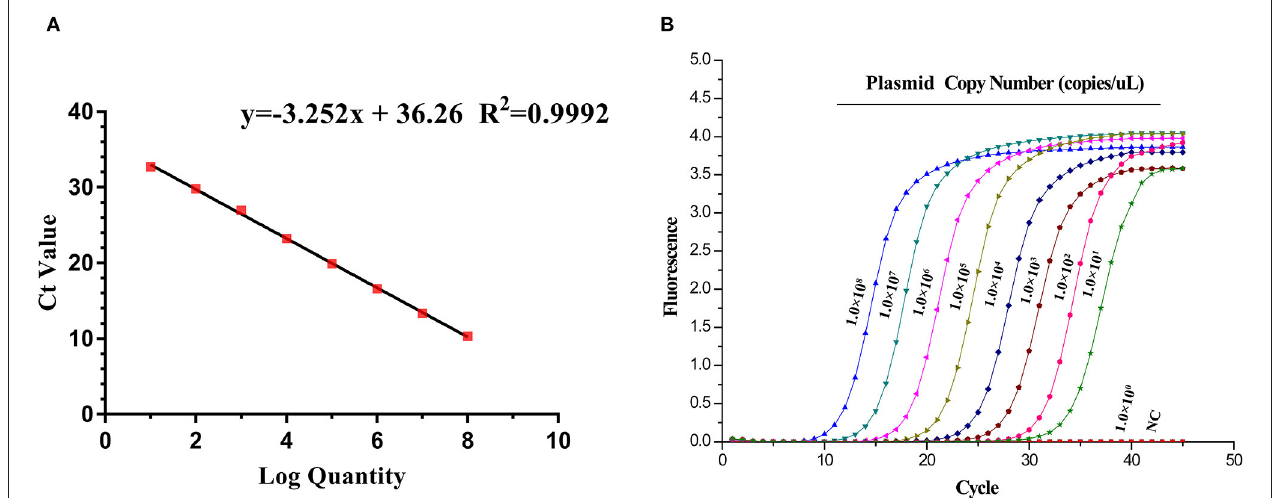
FIGURE 2 | Standard curve and sensitivity tests for A137R gene-based real-time PCR assay of ASFV. (A) Establishment of standard curve for A137R gene-based real-time PCR. The 10-fold serial dilutions ranging from 1.0 × 10 8 to 1.0 × 10 1 copies/ µ L of DNA plasmid were tested in the real-time PCR. Each point corresponds to the mean value of three replicates. The optimal standard formula is y = − 3.252x + 36.26, and the correlation coefficient is 0.9992. (B) Sensitivity tests for A137R gene-based real-time PCR assay of ASFV. Ten-fold serial dilutions of the DNA plasmid were used to perform the real-time PCR to obtain the expanded curve of the